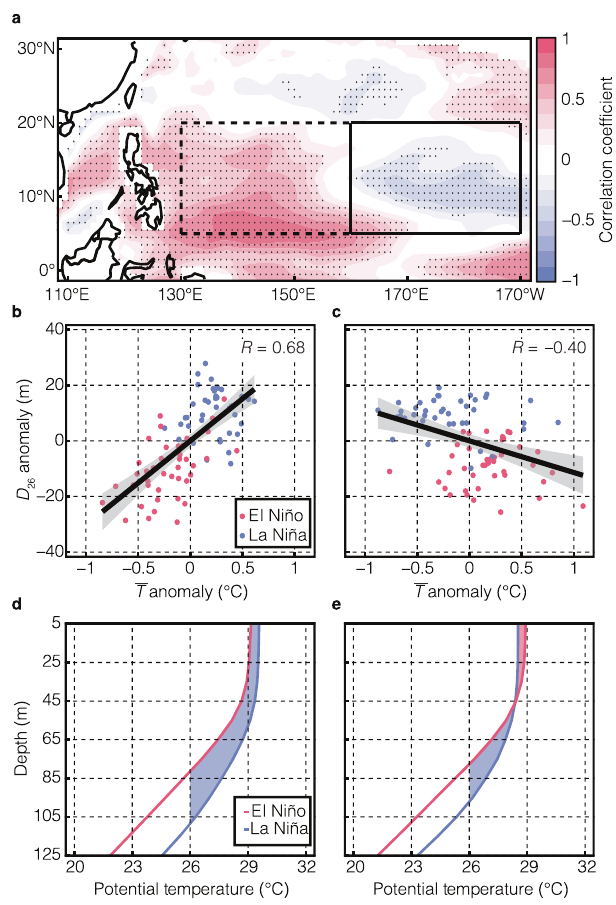
-- T ) and 26°C Fig. 4 | Opposite correlations between the upper mixed layer ( isotherm depth ( D 26 ) in the tropical northwestern Paci fi c and the tropical central-north Paci fi c. a Correlation coef fi cients between (cid:1) T and D 26 during all months listed in Supplementary Table S1. The black dots indicate that the corre- lations are statistically signi fi cant at the 95% con fi dence level. b The scatter plot of mean (cid:1) T anomaliesand D 26 anomaliesaveragedinthetropicalnorthwesternPaci fi c (the dashed box). The red and blue dots indicate El Niño and LaNiña,respectively. c Same as b , but for the tropical central-north Paci fi c (the solid box). The 95% con fi dence interval of the trendline is depicted in gray. d Vertical pro fi les of potential temperature for the dashed box. e Same as d but for the solid box. The shaded regions delineate the difference of upper layer heat content between El Niño and La Niña. The blue regions indicate the upper layer heat content is lower duringElNiño,whiletheredregionindicatestheupperlayerheatcontentishigher during El